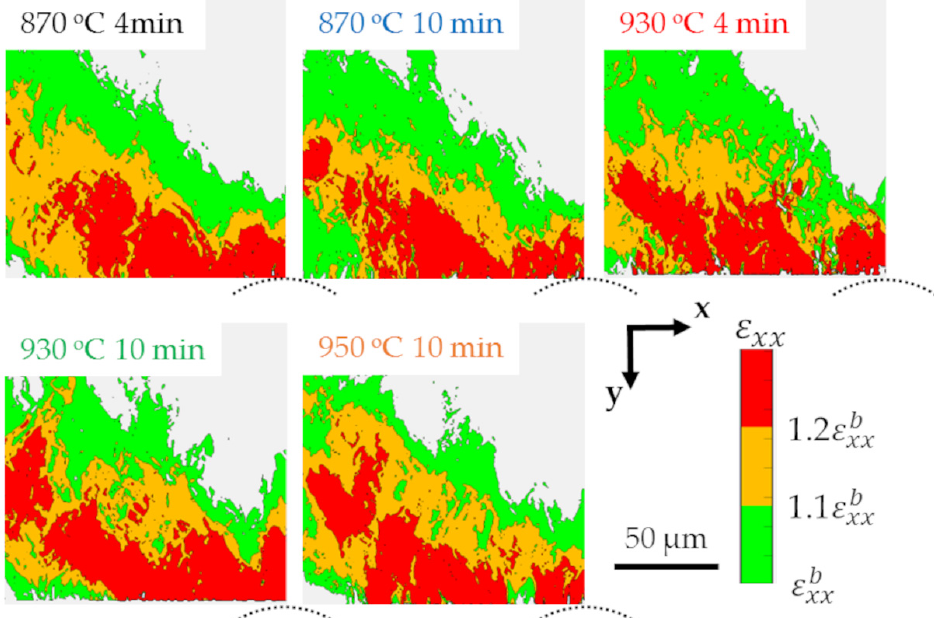
Figure 8. The distribution of axial strain, ε xx , in a 135-by-135 µ m 2 region close to the notch (marked in Figure 6a as ‘region of interest’) in the single-edge notch specimens of the five heat-treated martensitic steel deformed to a macroscopic normalized extension, δ / L 0 , of 0.05 ± 0.003. The loading direction is along the x-axis and the dotted arcs mark the initial location of the notch tip.